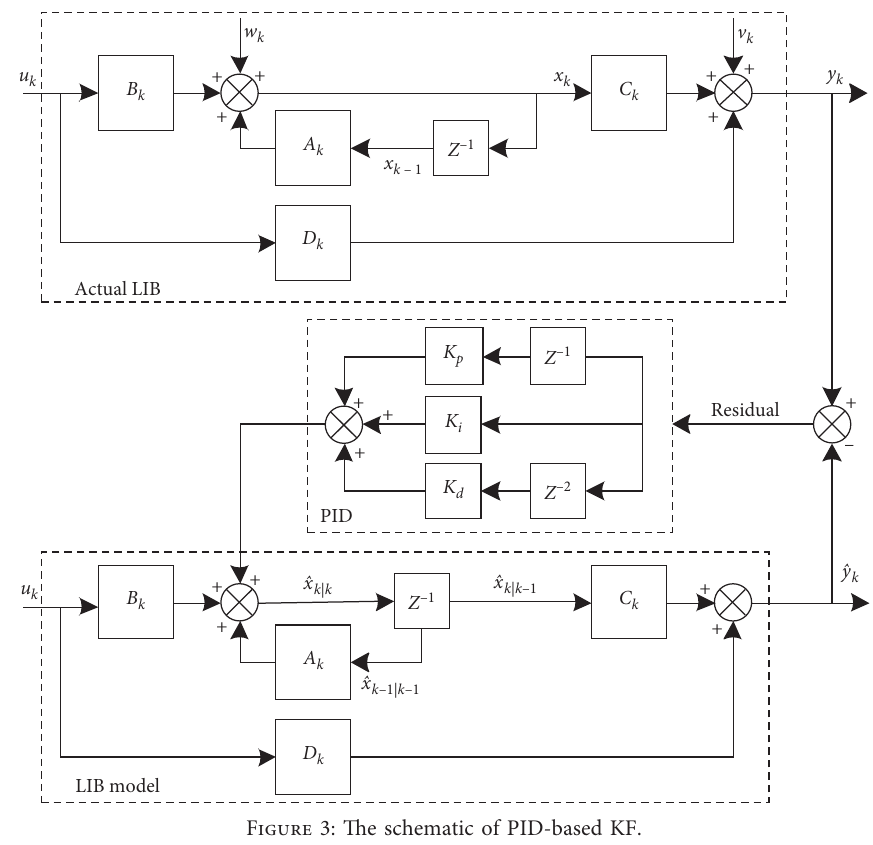
Figure 3: The schematic of PID-based